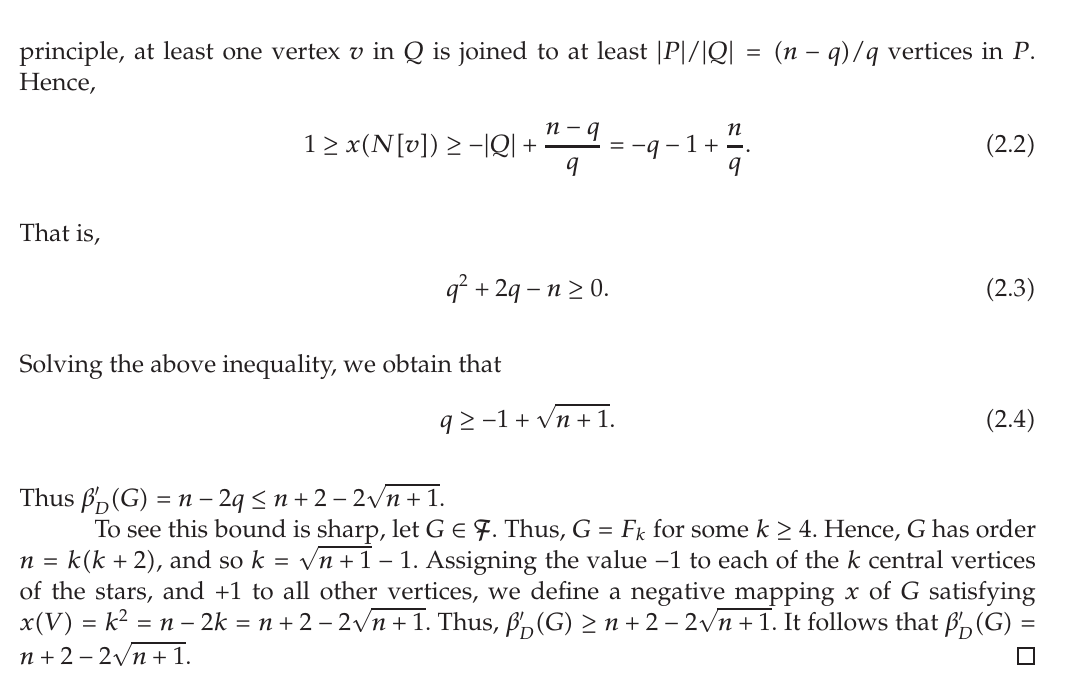
Figure 1: A copy of the graph F 4